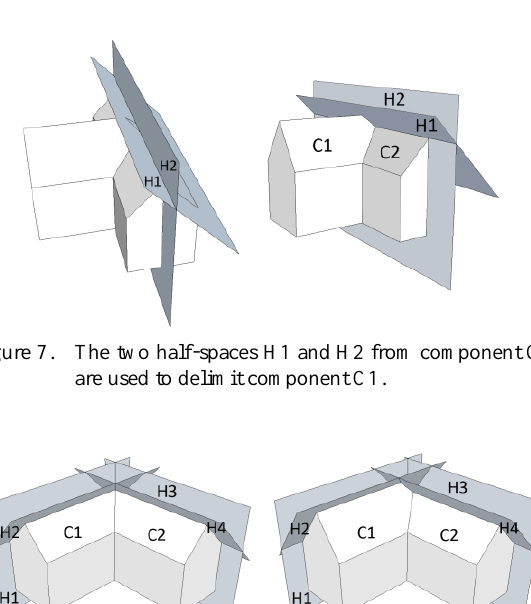
Figure 6. Three cases of a T-shaped ridge intersection.